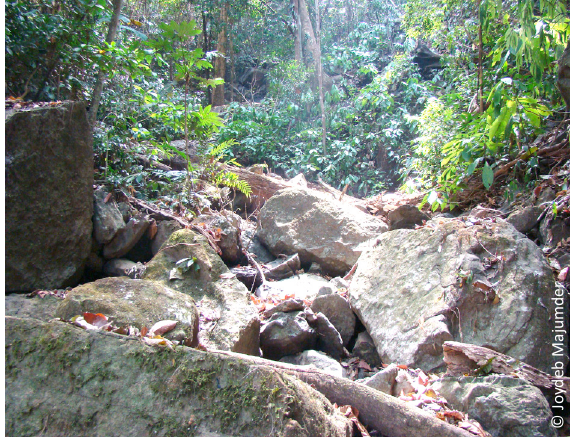
Image 2. Part of habitat of Tupaia belangeri